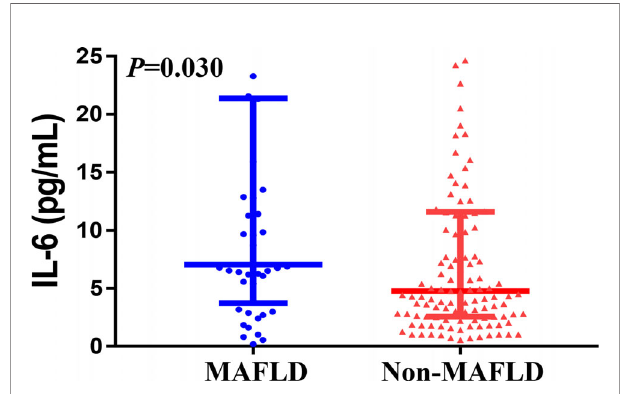
FIGURE 2 | The association between IL-6 levels and MAFLD status among COVID-19